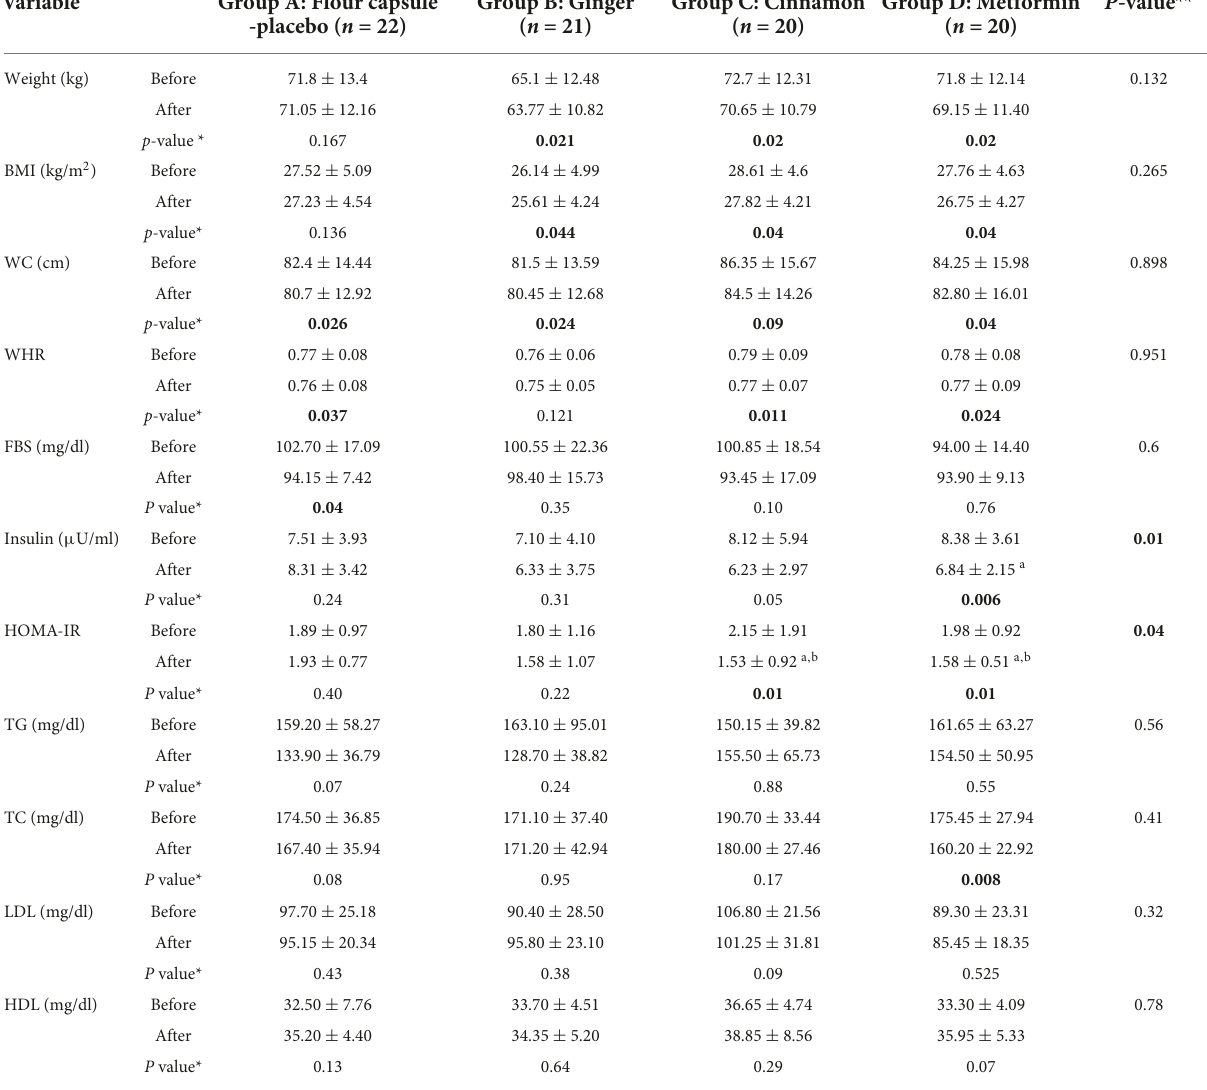
TABLE 4 Lipid profile, anthropometric and glycemic indices of the patients before and after intervention. Variable Group A: Flour capsule